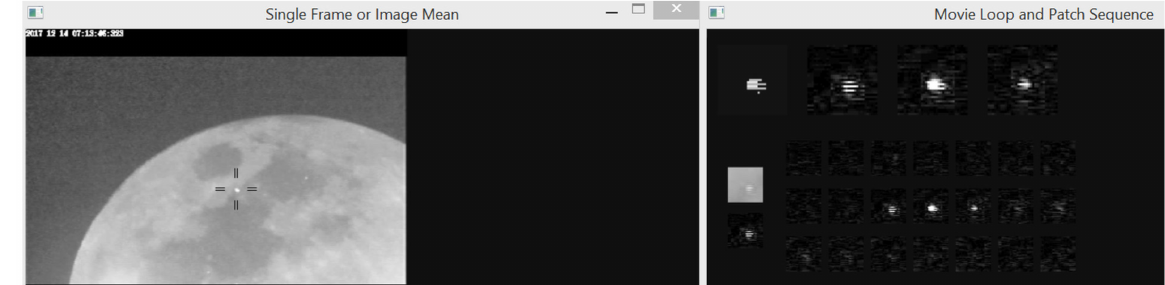
Figure 5. LunarScan windows displaying Flash 1 from the Araruna